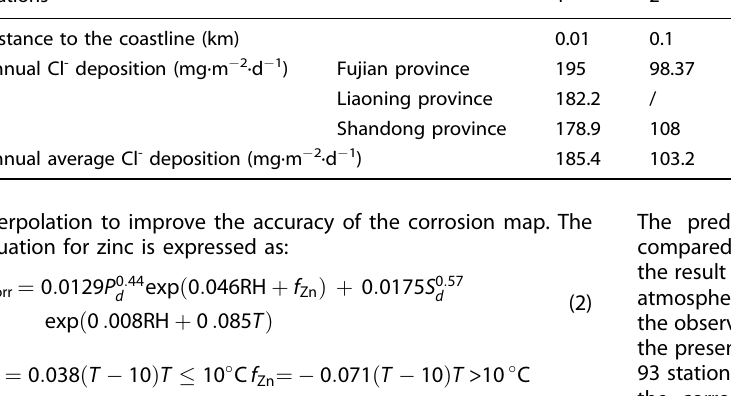
Table 1. The deposition rate of chloride for environment monitor stations along the distance to the coastline. Stations Distance to the coastline